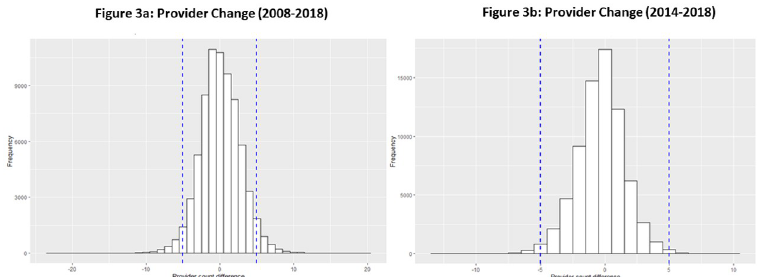
Fig 3. Comparison of provider change over